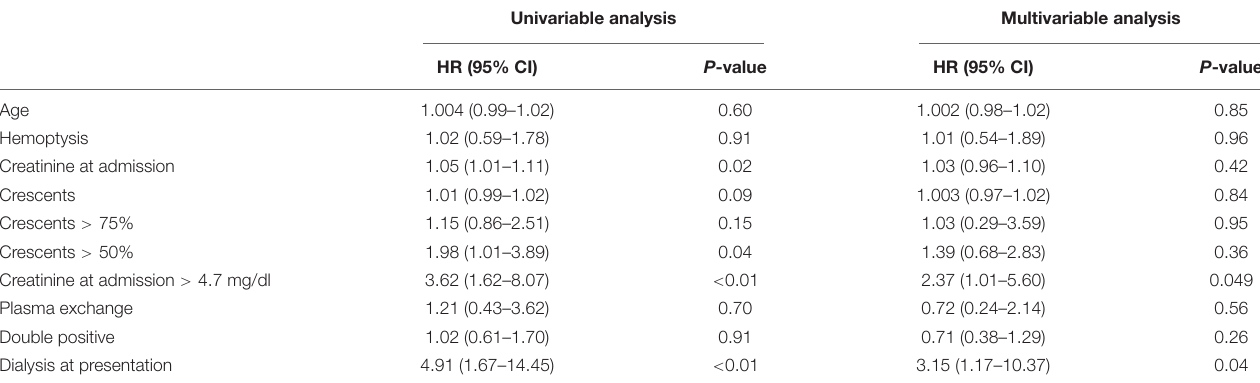
TABLE 4 | Prognostic parameters of ESKD.